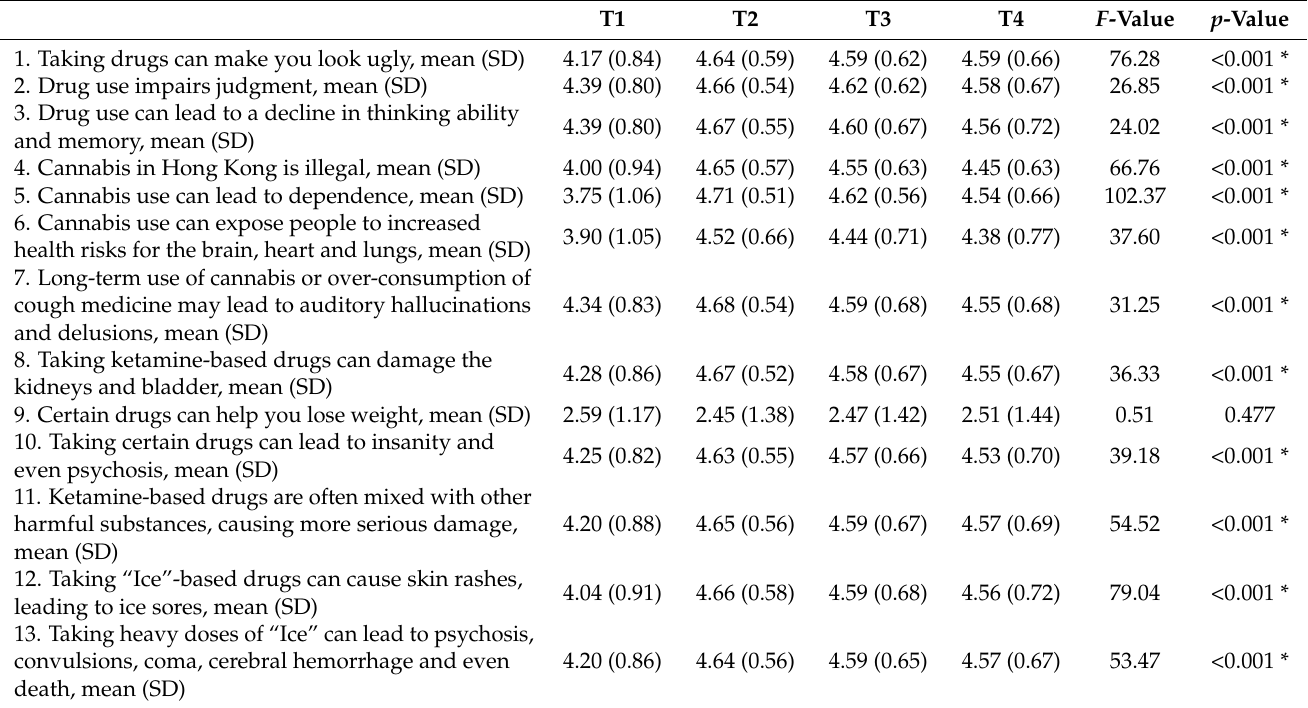
Table 2. Change in knowledge towards drug abuse among anti-drug ambassadors by repeated- measures ANOVA ( n = 198). T1 T2 T3